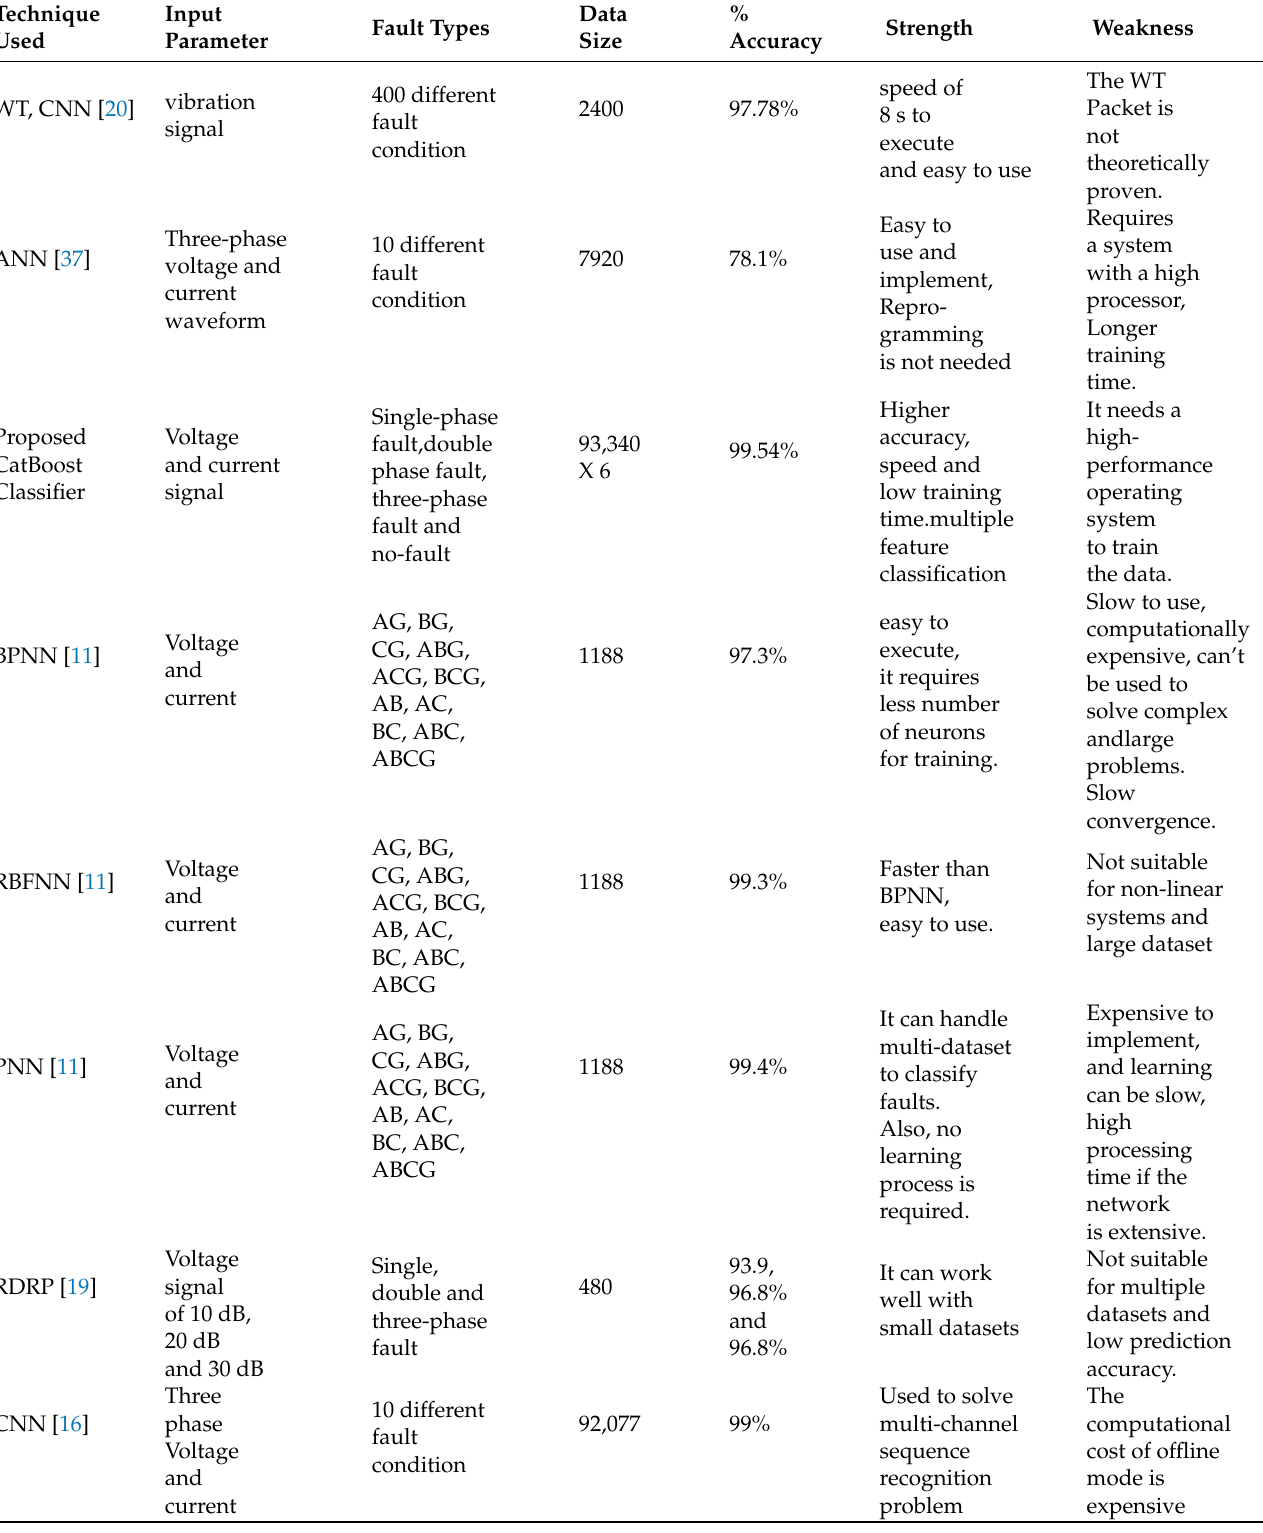
Table 7. Comparing different machine learning techniques for accuracy in fault